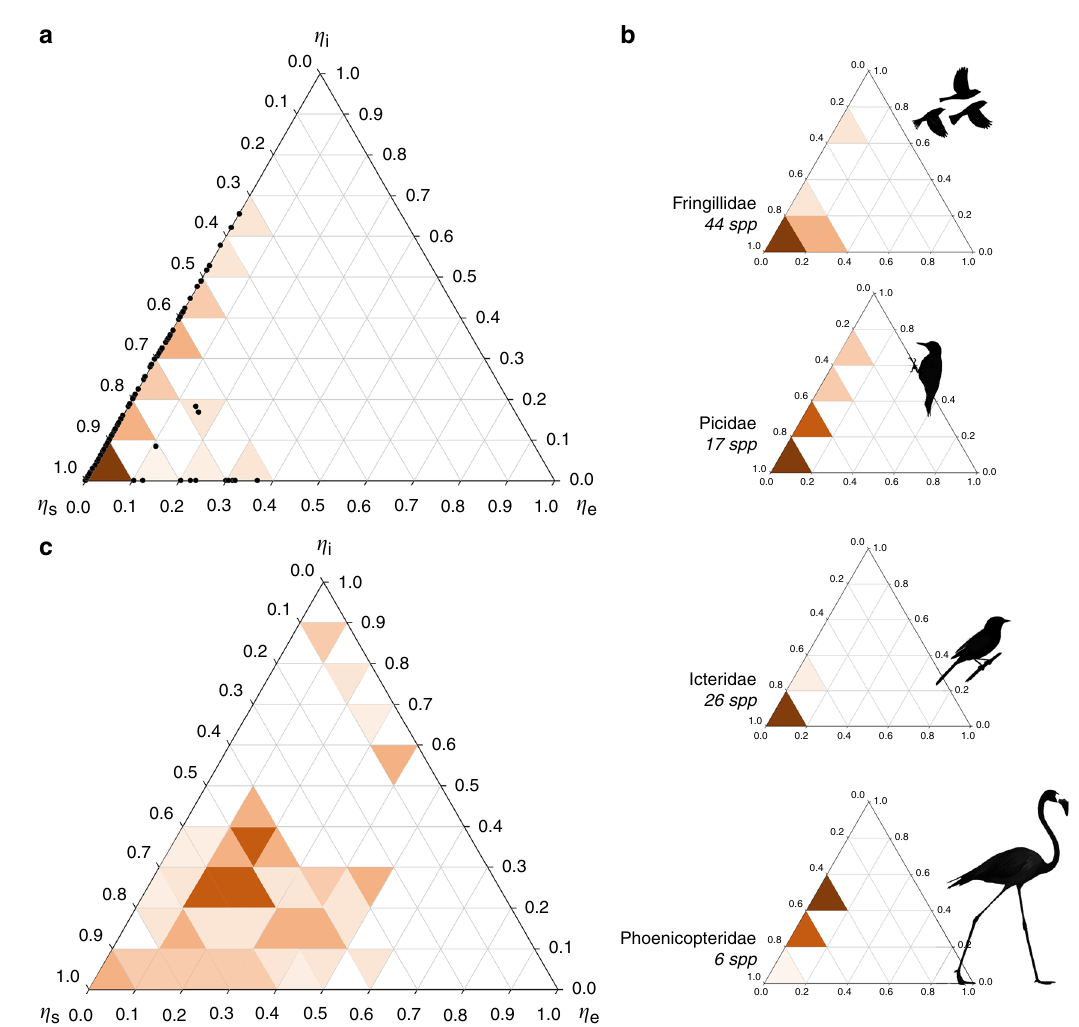
Fig. 2 Distinct control pro fi les of avian carotenoid networks and their randomized counterparts. a Heatmap of control pro fi les for networks of 250 bird species, projected to a ternary plot, reveals source-dominance, a signi fi cant extent of internal control, a de fi cit of sink controls, and a lack of mixed controls. Shades indicate density of networks (in 10% increments) with control pro fi les in that ternary space, data points are individual species. b Clustering of network control pro fi les of selected clades of birds with signi fi cant internal controls (Supplementary Fig. 1 shows additional clades). c ER randomization reveals that avian networks avoid mixed controls, have greater redundancy in source controls, and accumulate more enzymatic expansions that need internal controls than their randomized counterparts of the same size and complexity (Supplementary Fig. 2). Drawing sources are in Supplementary Fig.